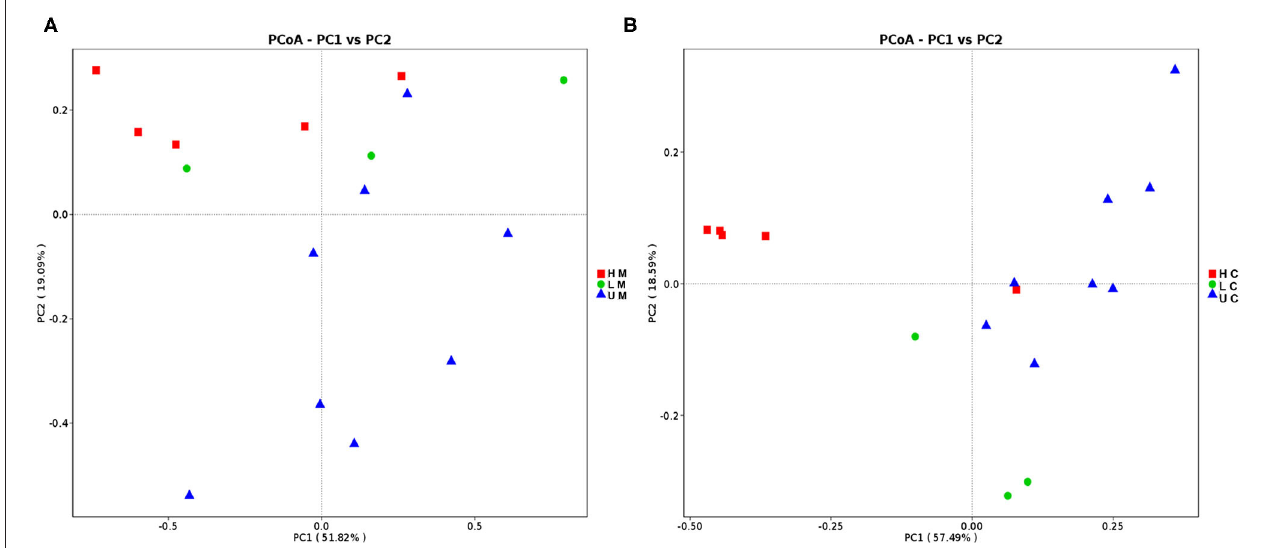
FIGURE 1 | Principal coordinates analysis (PCoA) of jejunal mucosa (A) and jejunal content (B) microbiome samples from uninfected, low viral load and high viral load groups. HM, jejunal mucosa microbiome samples from the high viral load group; LM, jejunal mucosa microbiome samples from the low viral load group; UM, jejunal mucosa microbiome samples from uninfected group; HC, jejunal content microbiome samples from the high viral load group; LC, jejunal content microbiome samples from the low viral load group; UC, jejunal content microbiome samples from the uninfected group.